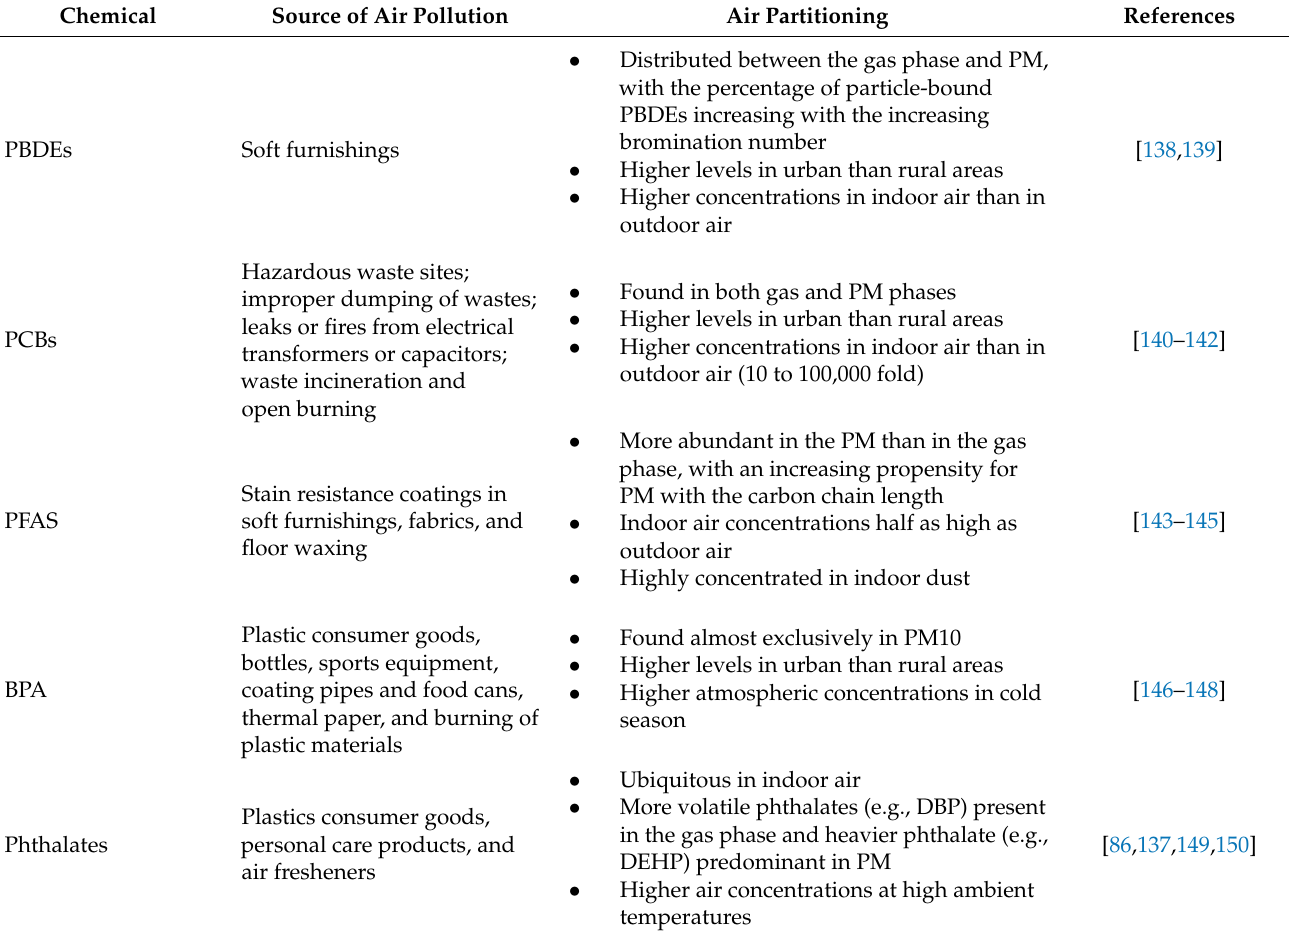
Table 2. Sources and air partitioning of endocrine-disrupting chemicals in